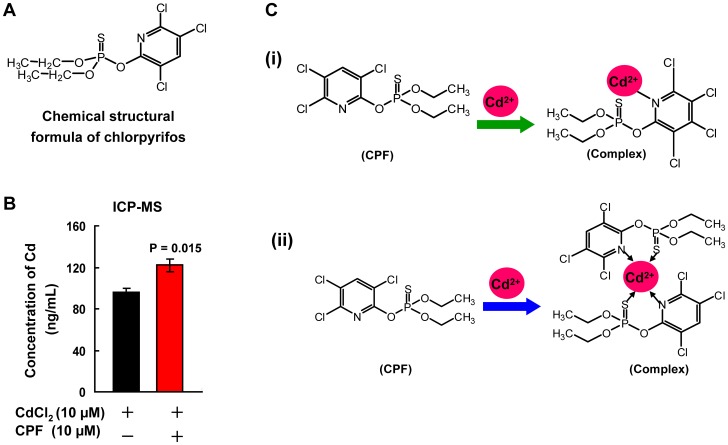
The facilitated intracellular transport of Cd2+ through the Cd-CPF complex.(a) The chemical formula of CPF. (b) The intracellular Cd concentrations in cells treated with Cd2+ or Cd2++CPF (both at 10 µM) for 24 h assessed by ICP-MS (n = 3). (c) A schematic delineating the molecular interaction between Cd2+ and CPF. The interaction between Cd2+ and CPF might be the bonding between Cd2+ and nitrogen atom in the benzene ring of CPF (i), or the chelation between one Cd2+ and two CPF molecules (ii).